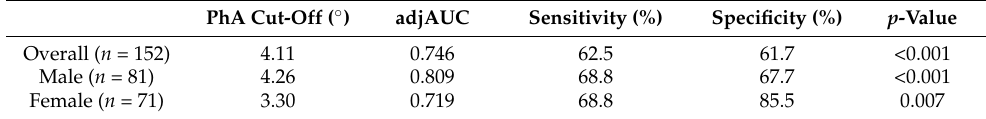
Figure 2. ( a ) Overall ROC curve analysis for PhA to detect PEW among HD patients; ( b ) ROC curve analysis for PhA according to gender to detect PEW among HD patients. Abbreviations: ROC, receiver operating characteristics; adjAUC, area under the curve adjusted for age, dialysis vintage, comorbidities, measurement quality, and overhydration. Table 3. Diagnostic Accuracy of PhA to detect PEW in HD patients ( n =